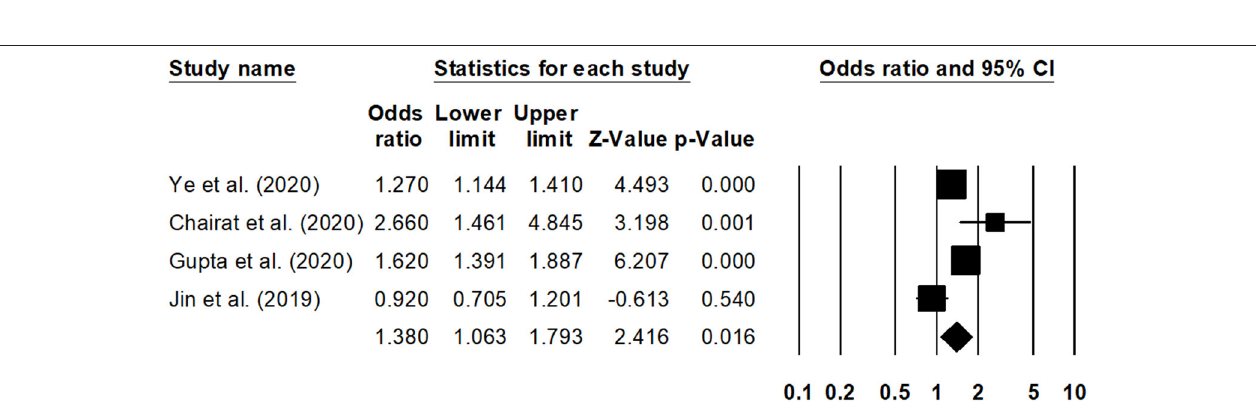
Frontiers in Cardiovascular Medicine |